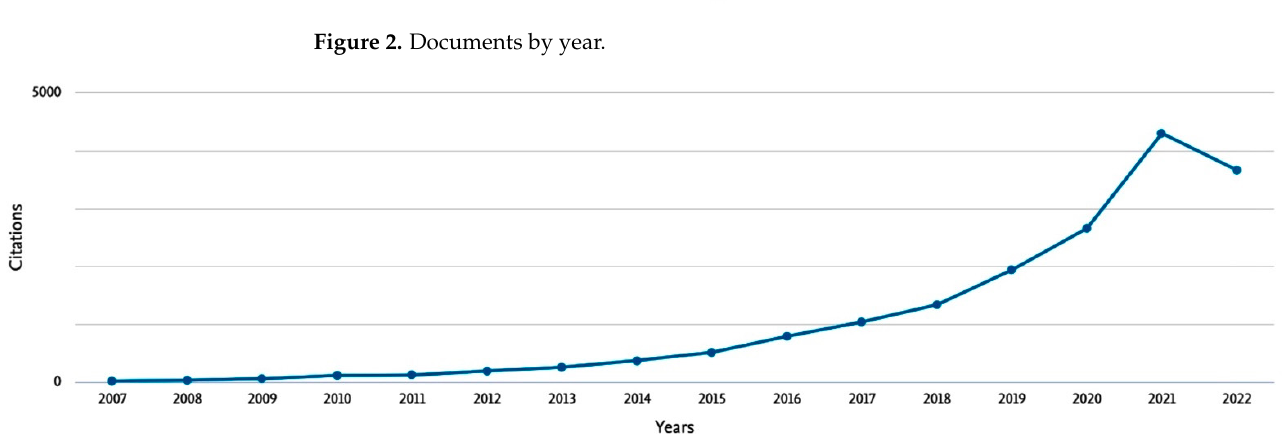
Figure 2. Documents by year.